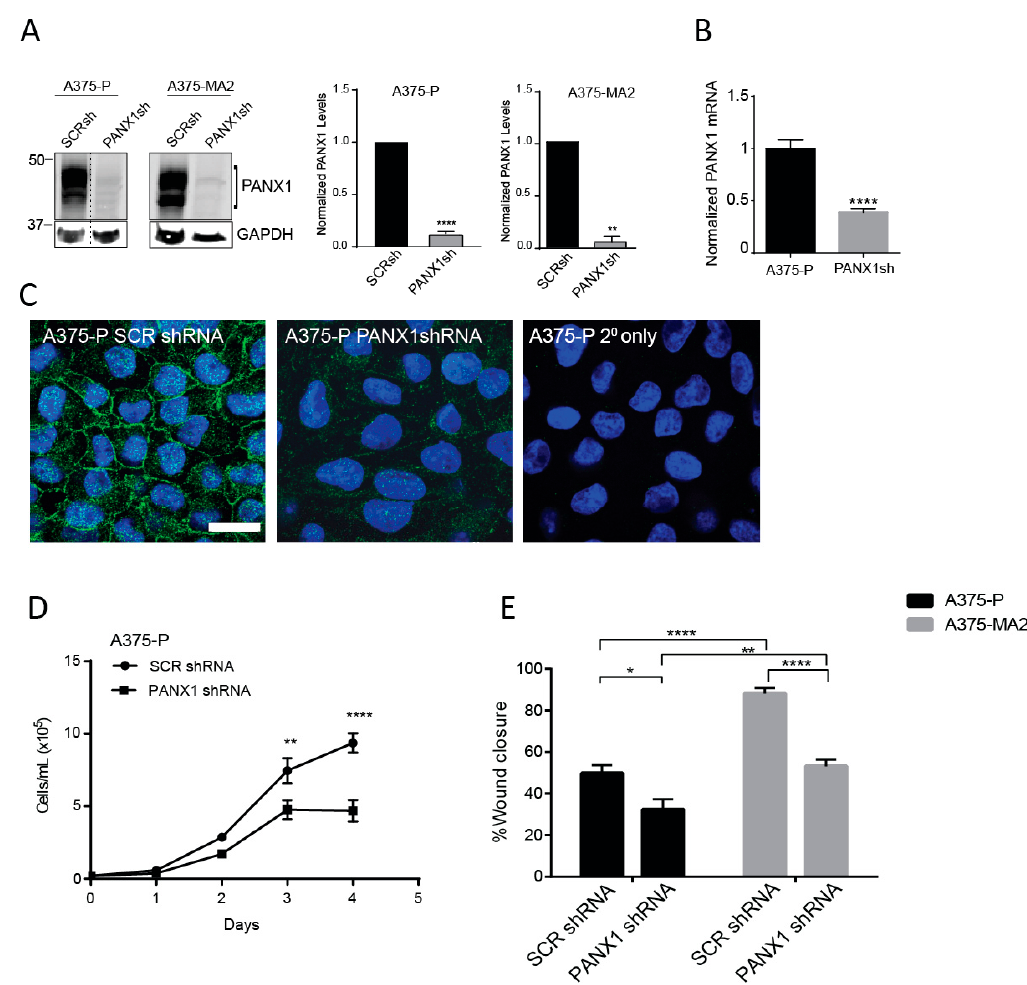
Figure 4. Knocking down PANX1 reduces growth and migration in human melanoma cells. ( A ) A375-P and A375-MA2 cells were transfected with either scrambled shRNA (SCRsh) as a control or shRNA constructs against PANX1 (PANX1sh). Western blot analysis confirmed PANX1 knockdown in both cell lines. GAPDH was used as loading control. Dotted line indicates extra lanes removed from the same blot scanned at the same intensity. Graphs depict the quantification of Western blots from three separate experiments conducted on different cell lysates, N = 3, student’s t -tests; **** p < 0.0001, ** p < 0.001 ( B ) PANX1 mRNA levels were measured by qPCR in control and PANX1 knockdown A375-P cells. Values in control samples were set to 1. Data are expressed as mean ± SEM, (N = 3, n = 9). Student’s t -test was used to analyse data; **** p < 0.0001. ( C ) A375-P cells transfected with scrambled shRNA (SCRshRNA, depicting PANX1 at the cell surface) or shRNA against PANX1 (PANX1shRNA, significantly reduced PANX1 signal) were fixed and stained with anti-PANX1 polyclonal antibodies (green). DNA was stained with Hoescht (blue). Staining with secondary antibody alone (2 ◦ only) was used as a control. Bar: 20 µ m. ( D ) A375-P cells transfected with either scrambled shRNA (SCR shRNA) or shRNA against PANX1 (PANX1shRNA) were cultured at 20,000 cells per well in medium containing 10% FBS. Cells were counted daily up to 4 days after initial seeding of the cells onto the culture. There was a significant reduction in cell growth after three days in cells with reduced levels of PANX1. The data are expressed as mean ± SEM from four separate experiments conducted with three technical replicates. (N = 4, n = 12). Two-way ANOVA was used to statistically analyze the data. ** p < 0.01, **** p < 0.0001. E. Scratch assays were performed on a confluent monolayer of Scrambled (SCRshRNA) and PANX1 knockdown (PANX1shRNA) A375-P and A375-MA2 cells to assess migration in growth media with chFBS. The distance travelled by the cells represents cell migration three days following the initial scratch and treatment application. Data are expressed as mean ± SEM (N = 3, n = 9).